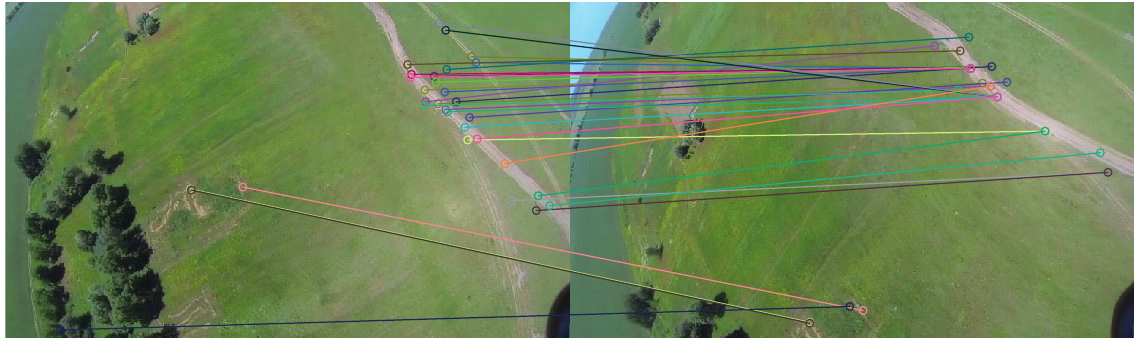
Fig. 6. The matching of two video frames from aboard a UAS with a difference of 40 frames (1.6 sec, 25 fps) done in (Code of SURF listing in MATLAB). The number of false matching is 9 from a total of 31 matching features. The average time for computing the matches is 0.0362